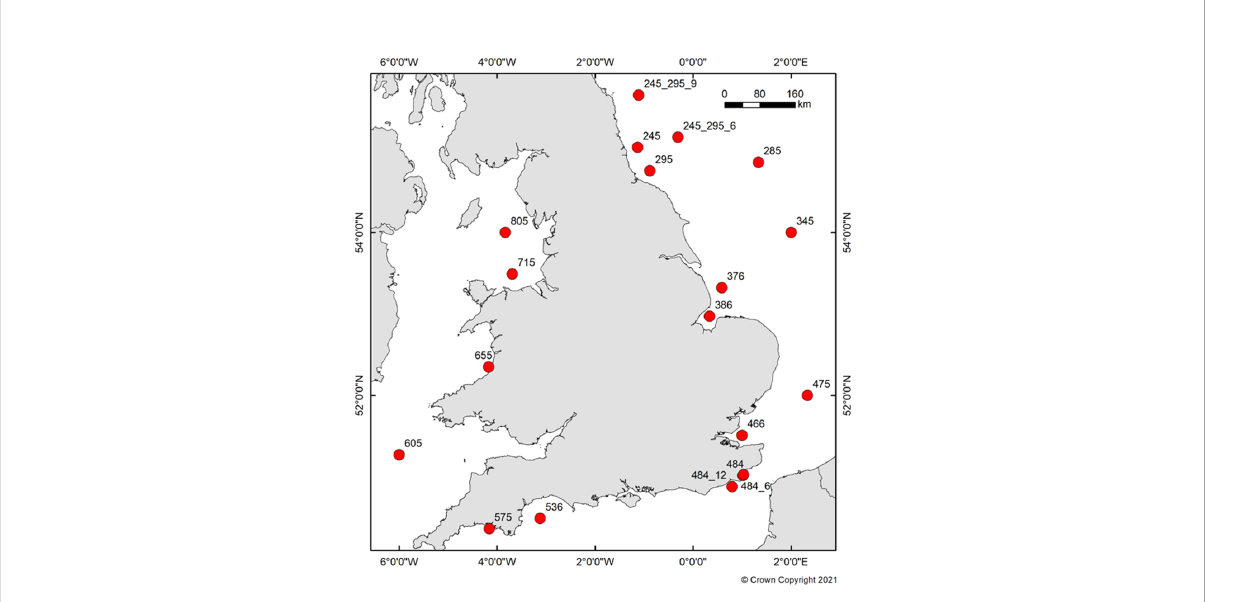
FIGURE 1 Clean Seas Environmental Monitoring Programme sediment